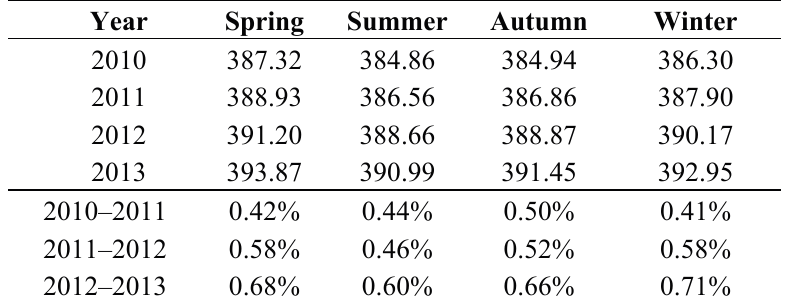
mole fraction (µmol·mol − 1 ; upper portion of the graph) and increase Table 1. Average CO 2 (lower portion of the graph) in four Seasons at Zhongshan